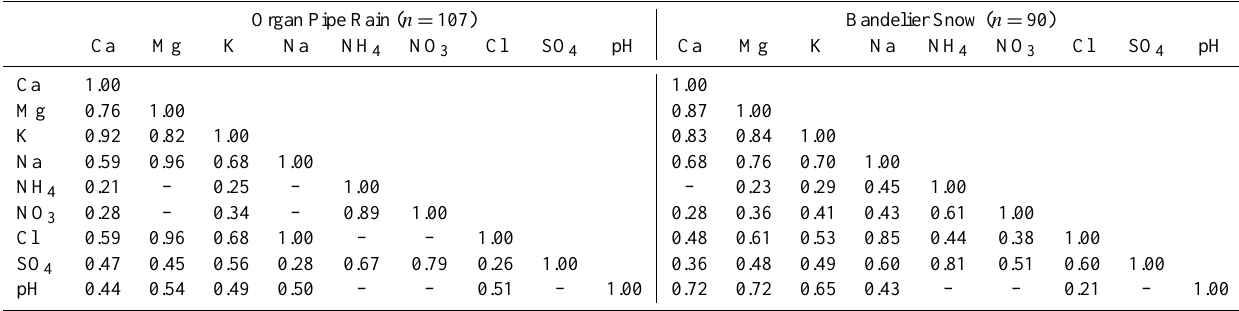
Table 2. Correlation matrix ( r values) for rain water constituent concentrations measured at Organ Pipe between 2003 and 2010 and snow water constituent concentrations measured at Bandelier between 1995 and 2010. Values are only shown when statistically significant (95%) with a two-tailed Student’s t test. Refer to Supplement for all data for the six sites.